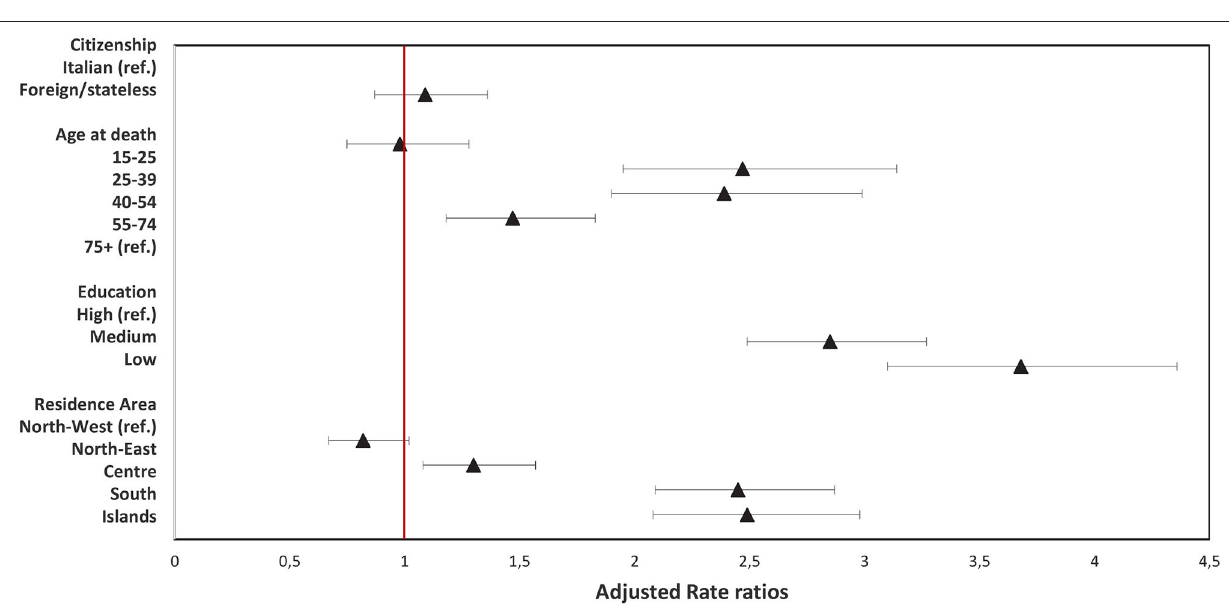
higher for those aged 25–54 years, with a risk of homicide more than double that of the ≥ 75 years age class. Moreover, a lowest education level (RRadj: 3.68; 95% CI: 3.10–4.36, low